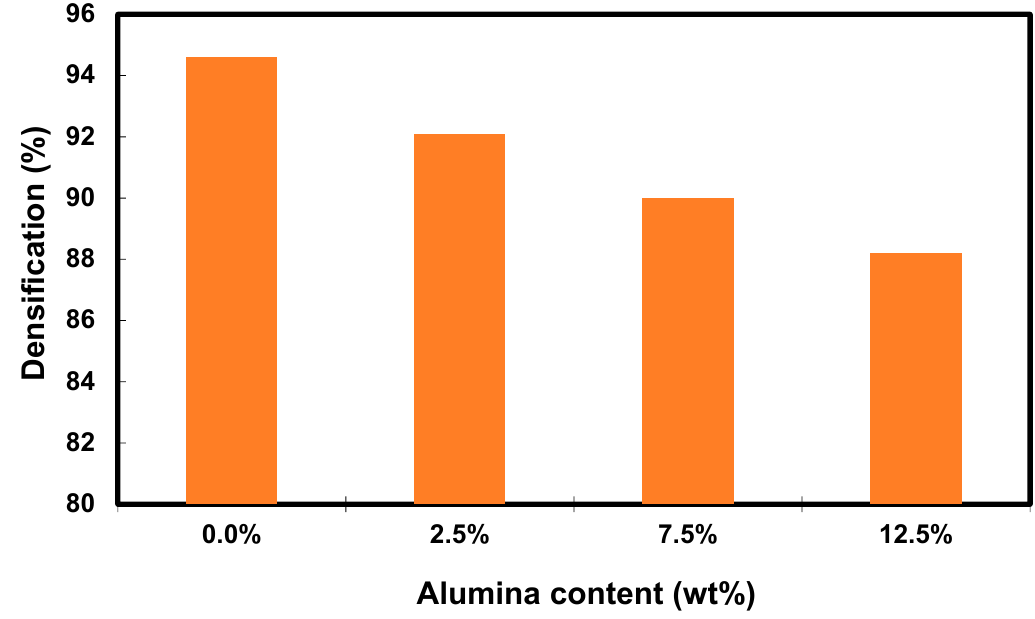
2 O 3 nanocomposite.